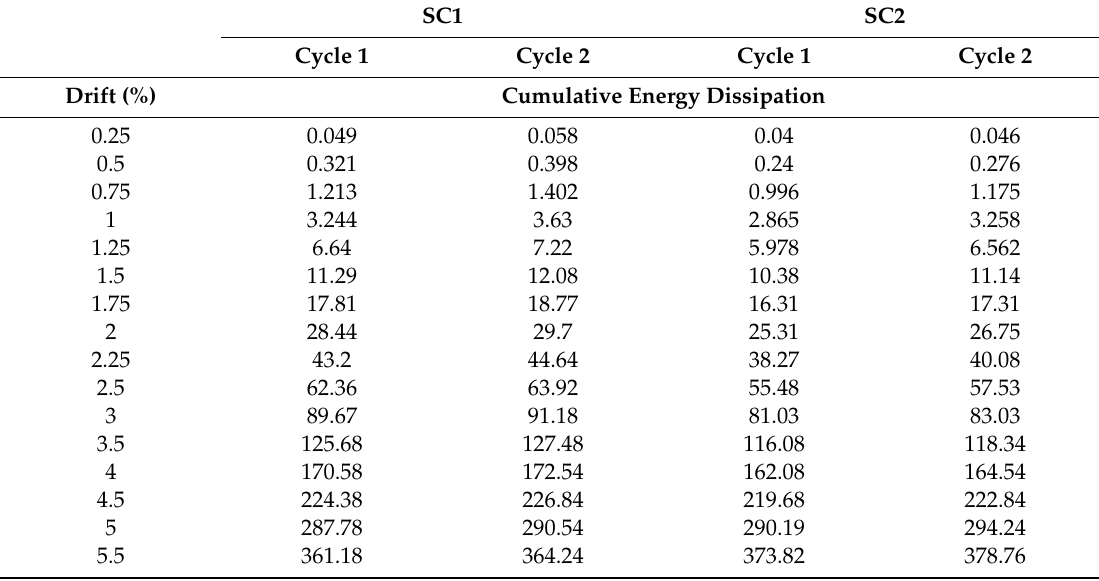
Figure 15. Cumulative energy dissipation versus drift. Table 5. Cumulative energy dissipation.